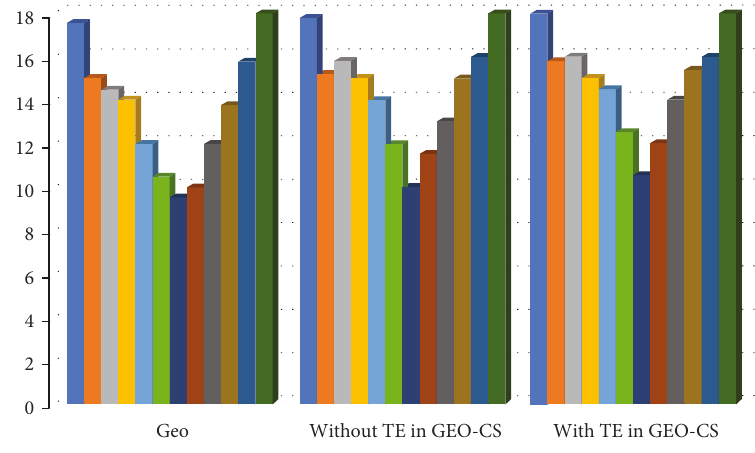
Figure 9: Comparison